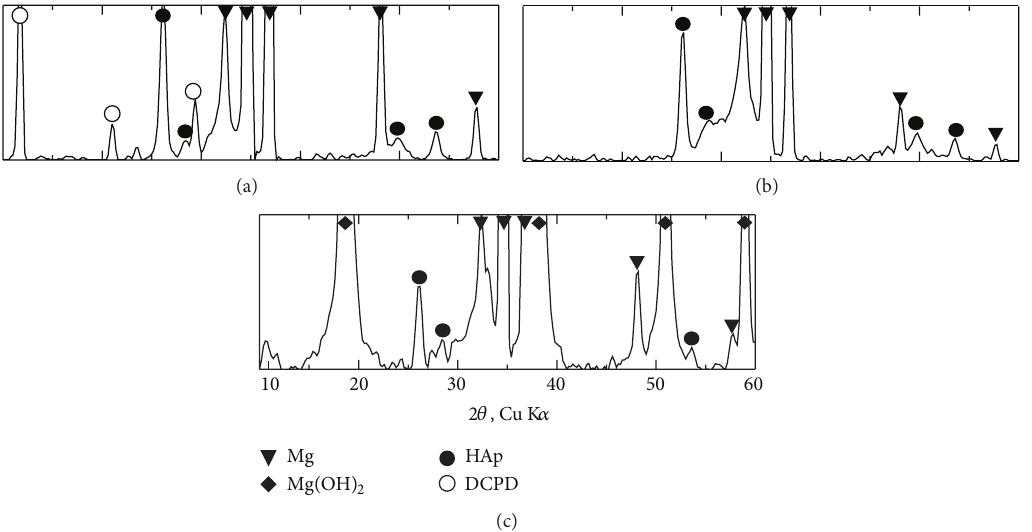
Figure 6: xrd patterns of coatings obtained at − 1.4V before and after immersion in SBF solution for 1 day and 7 days.